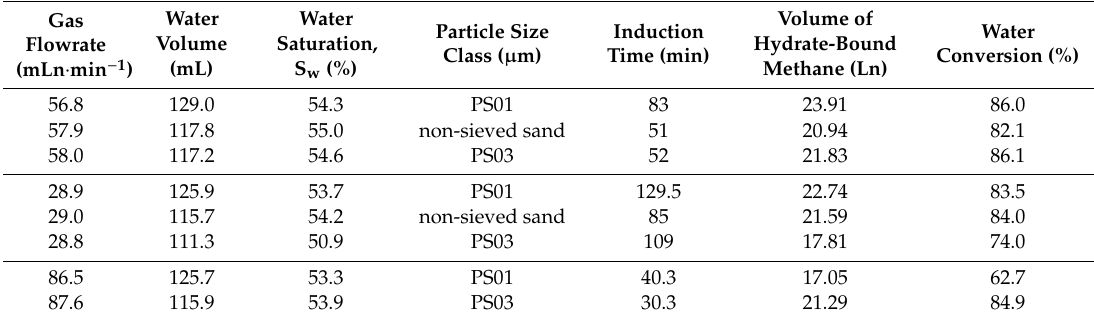
Table 4. Operating conditions and results obtained for methane hydrate formation and dissociation experiments with di ff erent classes of particle size and di ff erent gas flowrates.